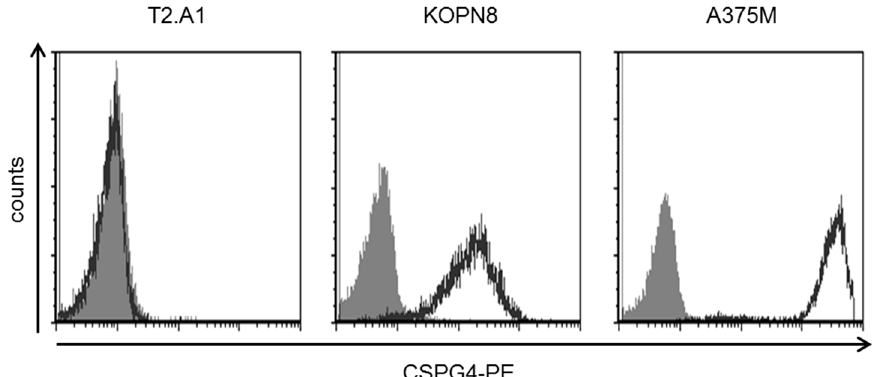
Figure 1. KOPN8 leukemia cells express CSPG4. Surface expression of CSPG4 on KOPN8 cells in comparison to CSG4-negative T2.A1 cells and CSPG4-positive A375M melanoma cells. One representative staining out of three independent experiments is shown.